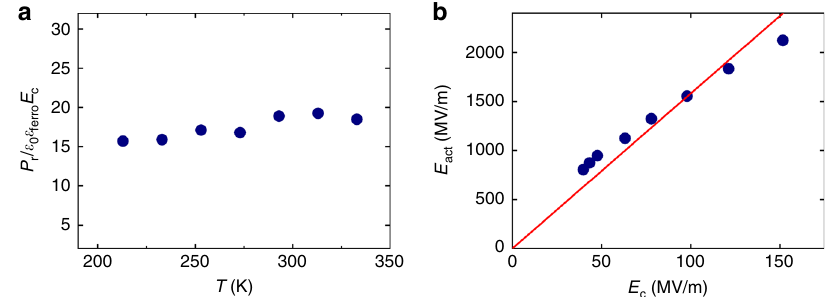
Fig. 7 Extracted ferroelectric parameters for the ideal model system P(VDF – TrFE). a Extracted value of P r / ε 0 ε ferro E c as a function of temperature for poly (vinylidene fl uoride-tri fl uoroethylene) [P(VDF – TrFE)]. b Activation fi eld as a function of coercive fi eld extracted from switching measurements on P(VDF – TrFE). The red line is a linear fi t through the origin, resulting in a slope of